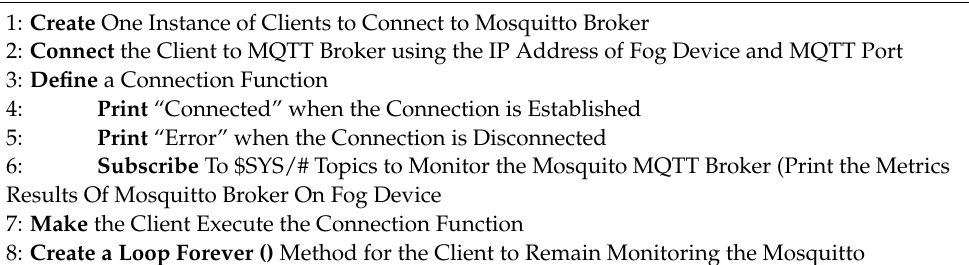
Algorithm 5. Monitoring script on fog device/*. This algorithm connects to the MQTT broker, subscribes to SYS-Topics via the MQTT broker to monitor and provide benchmark metrics of